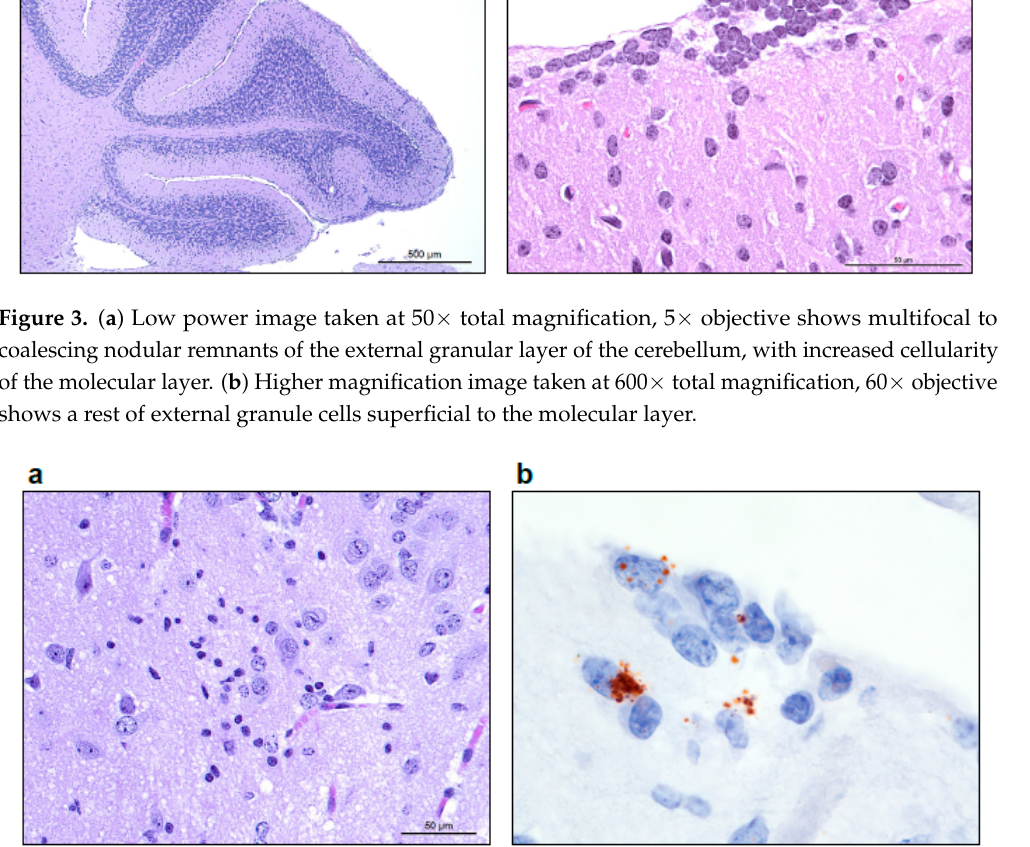
Table 3. Presence or absence (“+” or “-“) of semen- or breast milk-associated matrix toxicity at varying concentrations in vitro and survival in vivo at day 10 post-exposure.